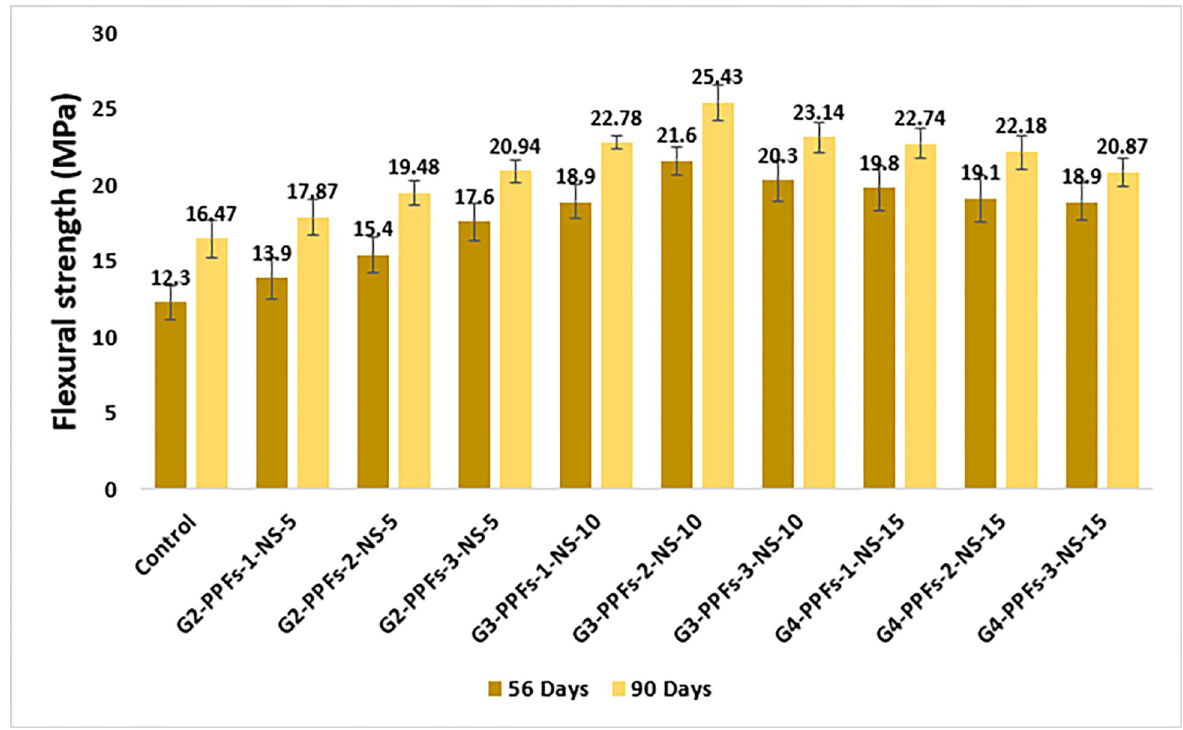
Fig 13. Flexural strength of UHS-GPC at 56 and 90 days.